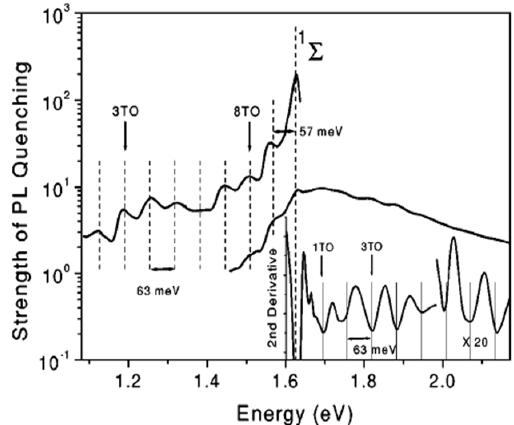
Figure 22. Spectral dependence of the PL quenching strength of por-Si with adsorbed O 2 molecules at T = 5 K. Inset shows the second derivative of the PL quenching strength. For convenient presentation, the data are partially scaled by the indicated multiplication factor. Vertical dotted lines are guide for the eye. (From Reference [65]).